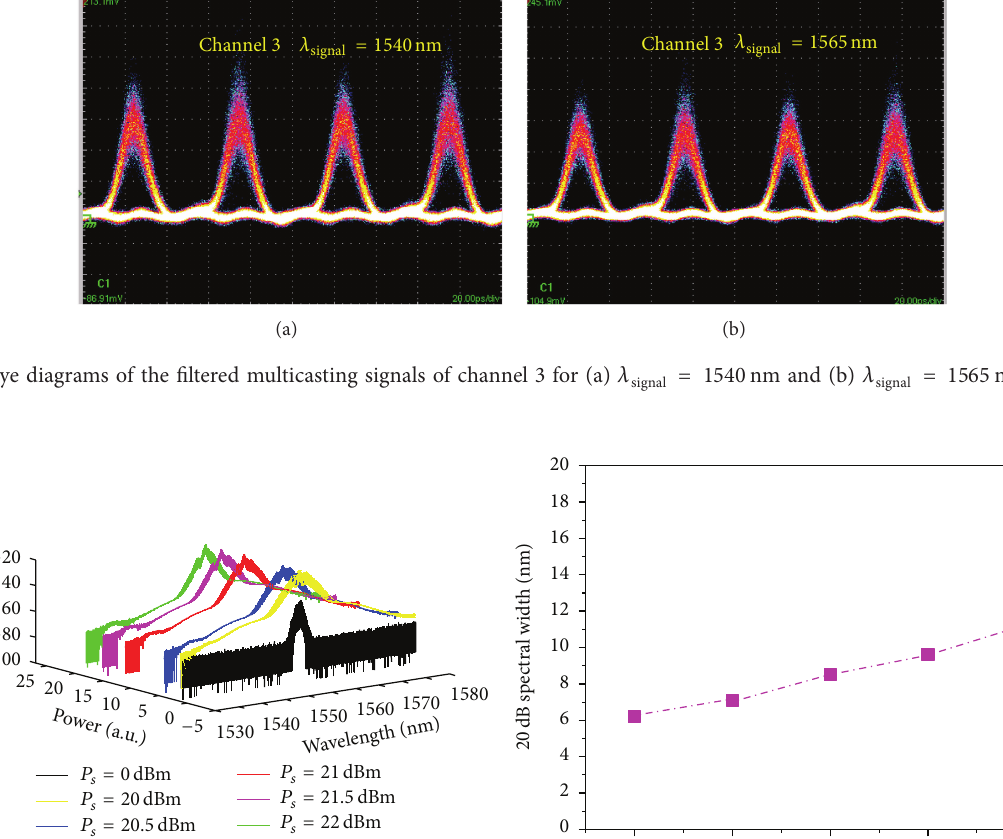
= 1540 nm and (b) 𝜆 = 1565 nm. signal signal